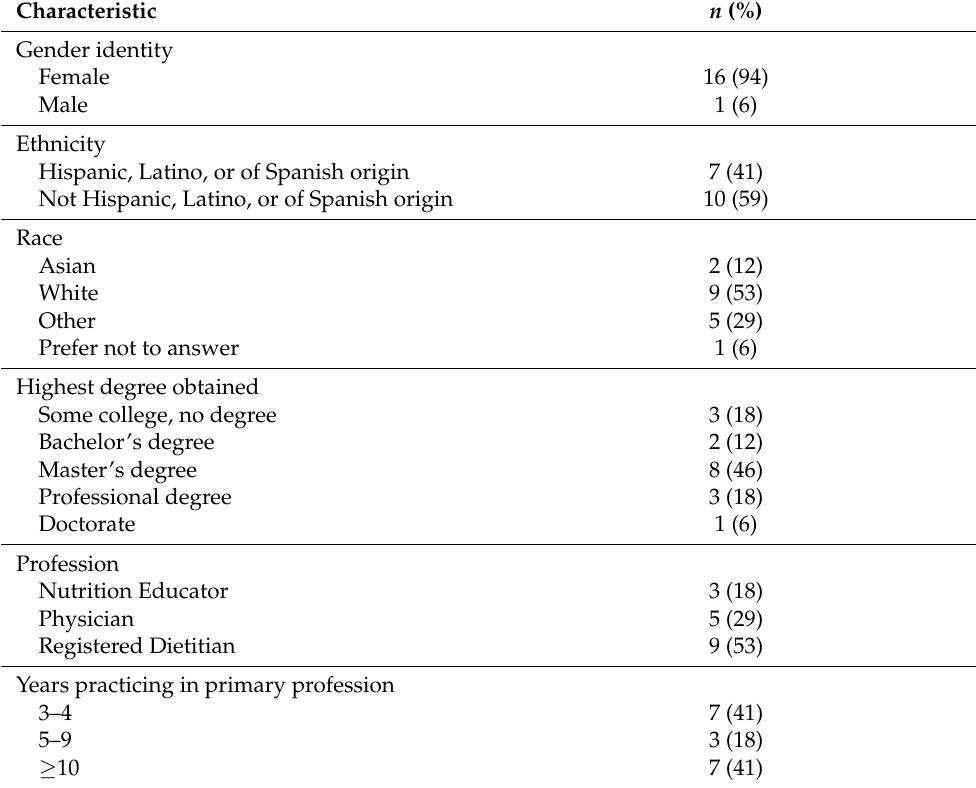
Table 3. Sociodemographic and digital use characteristics of stakeholder participants ( n =